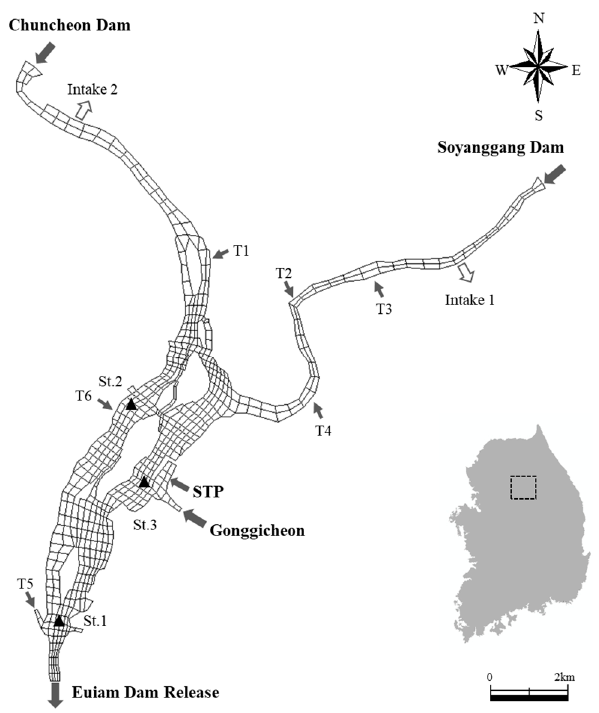
Figure 1. Representation of model boundary (Chunchoen Dam, Soyanggang Dam, Gonggicheon, STP, six tributaries (T1–T6), two intake stations, and Euiam Dam release) and the monitoring locations (St. 1, 2, and 3) in the study area.